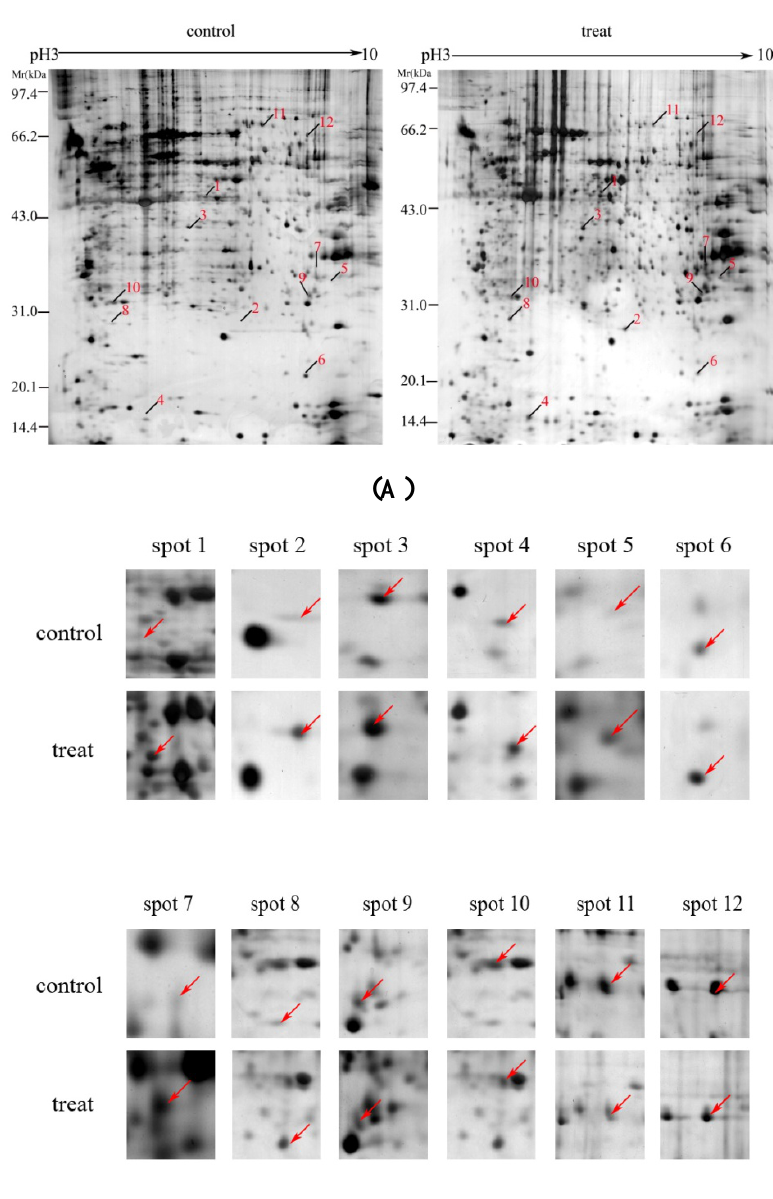
Figure 3. The proteome maps (2-DE images) of osteoblastic UMR 106 cells. Molecular weight (MW, kDa) and isoelectric point ( pI ) are indicated along the y- and x-axis, respectively (A). Selected regions show significant differences in the protein expression profile of osteoblasts (B) between untreated and those treated with 100 µg/mL of EXD for 48 h. Arrows indicate proteins that are differentially expressed absolutely. The gel images are representative gels from among nine replicate gels collected from three independent experiments. Differentially expressed protein spots indicated by lines and numbers were chosen for MALDI-TOF MS/MS analysis, outlined in Table